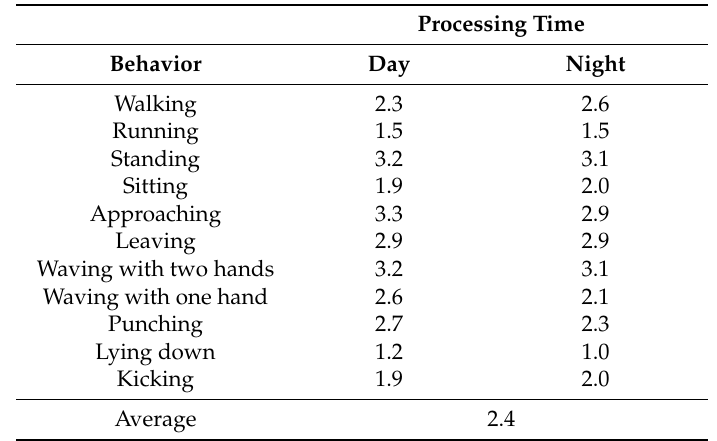
Table 6. Processing time of our method for each behavior dataset (unit: ms/frame).